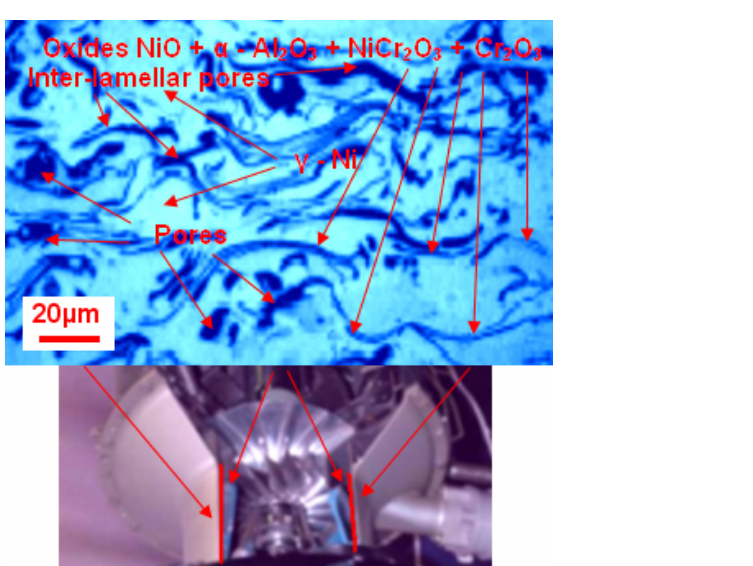
Figure 3 – Casing frame of the ASTAZOU III B turbojet engine and the microstructure of the Ni19Cr6Al coating Рис . 3 – Входная кромка корпуса турбореактивного двигателя ASTAZOU III B и микроструктура покрытия Ni19Cr6Al